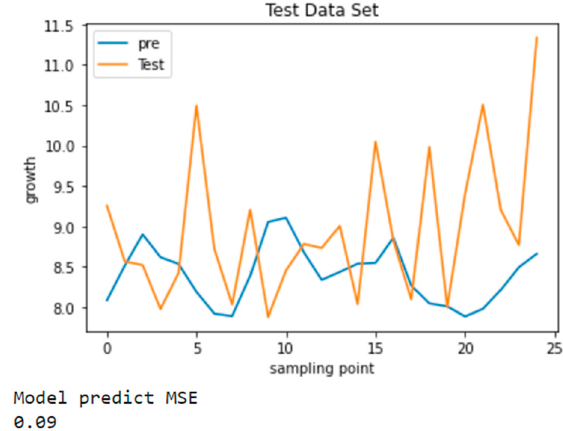
Figure 8. The MSE is significantly improved after retraining